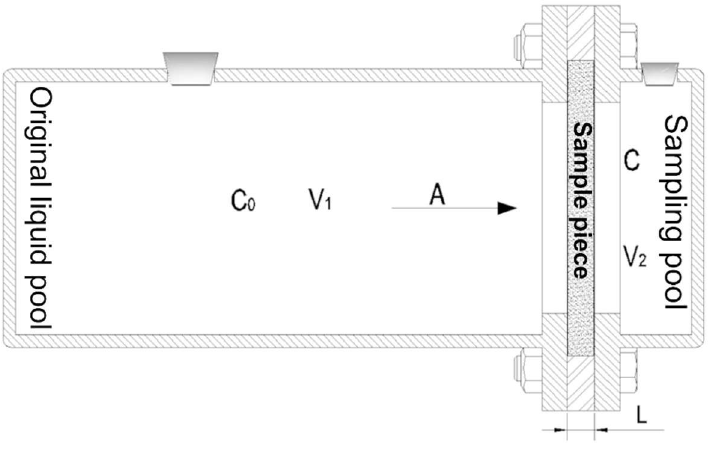
Figure 1. Constant source diffusion experimental device.